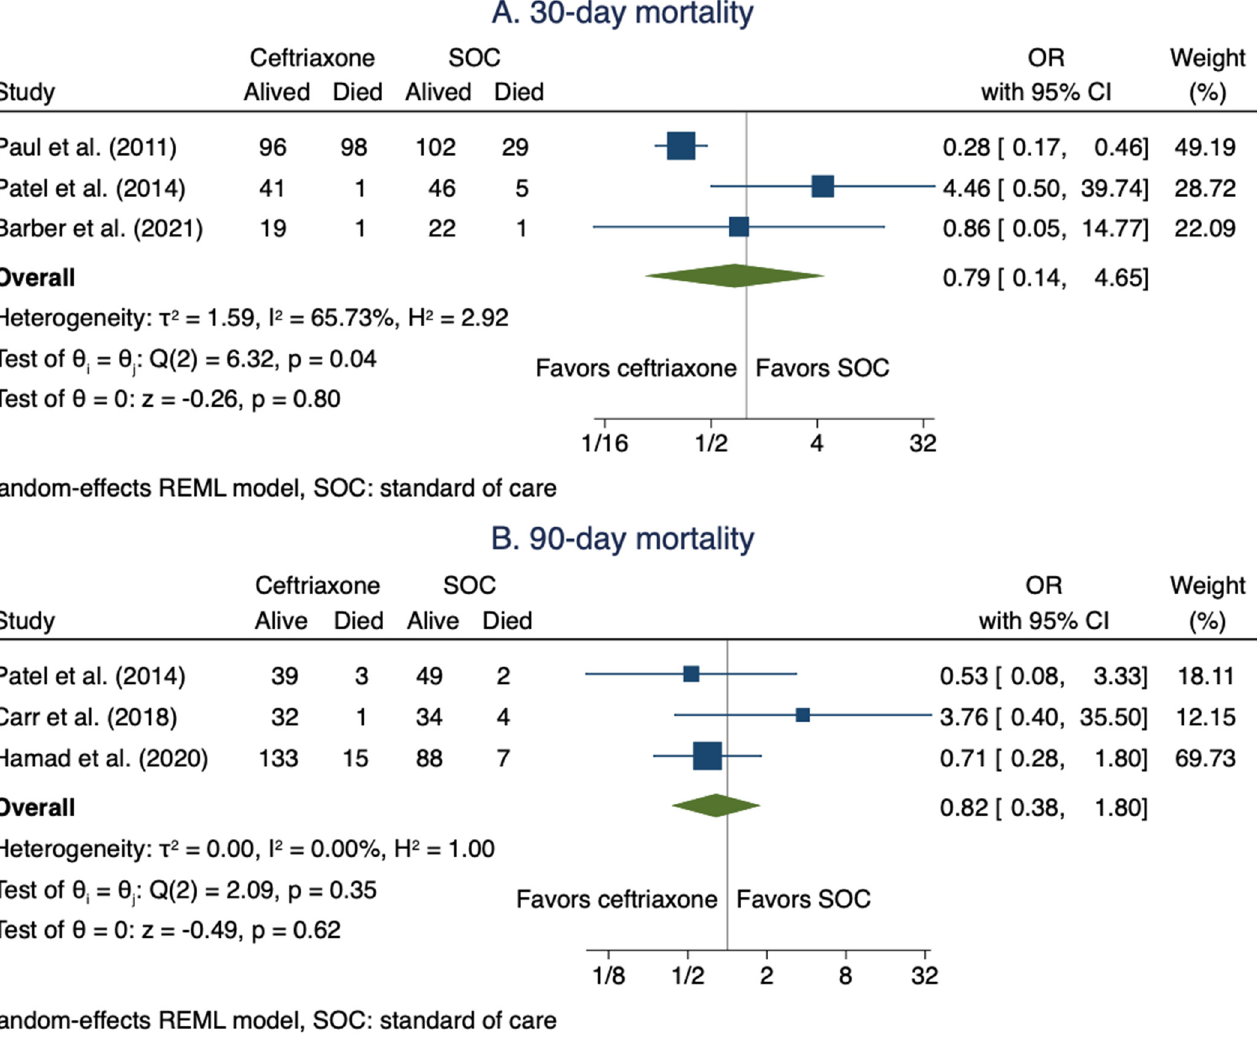
Figure 3. Meta-analysis of 30-day mortality ( A ) and 90-day mortality ( B ).